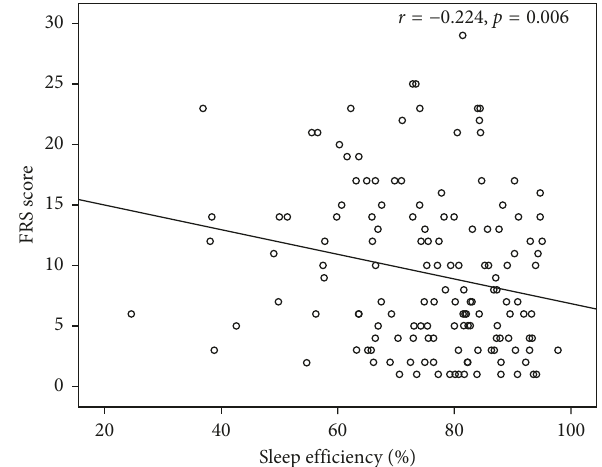
Figure 5: Association between Framingham Risk Score (FRS) and sleep efficiency in obstructive sleep apnea syndrome